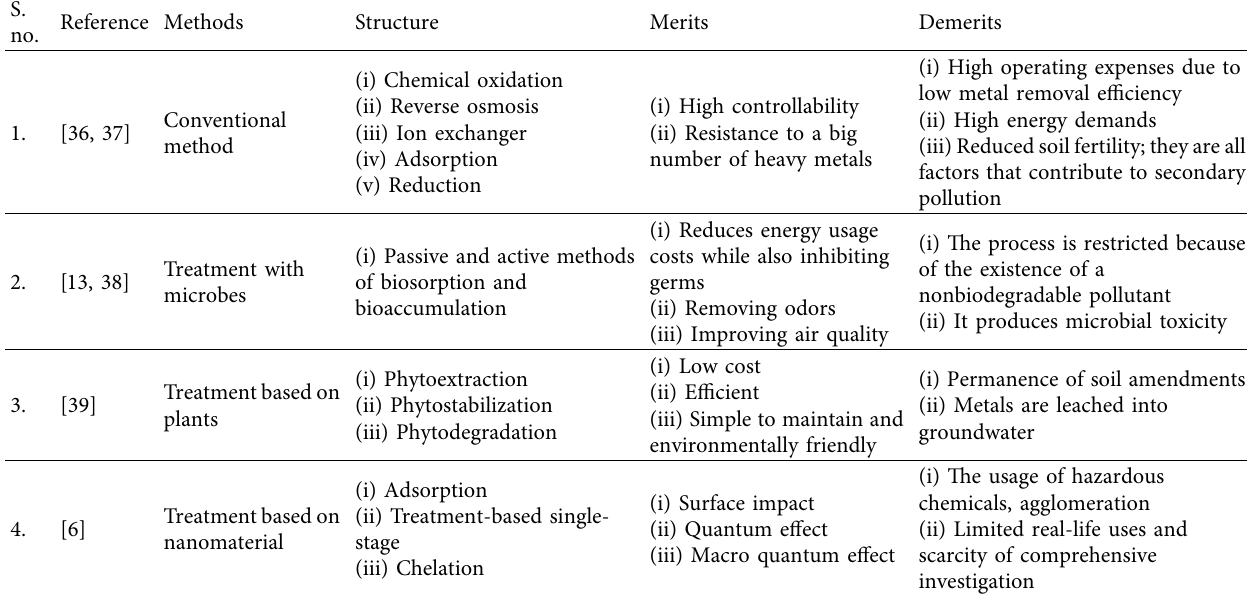
Table 2: Comparisons between several HMR